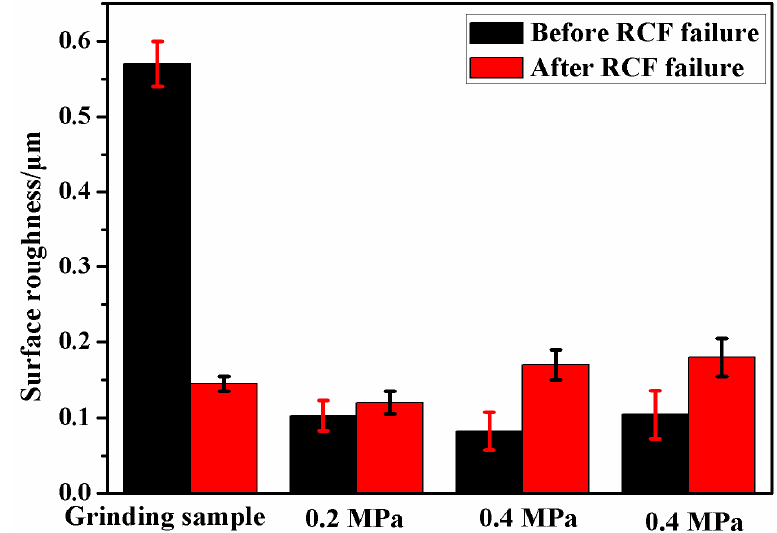
Figure 6. The surface roughness of the grinding processing sample and the sample after SURT with different static pressures before and after RCF.